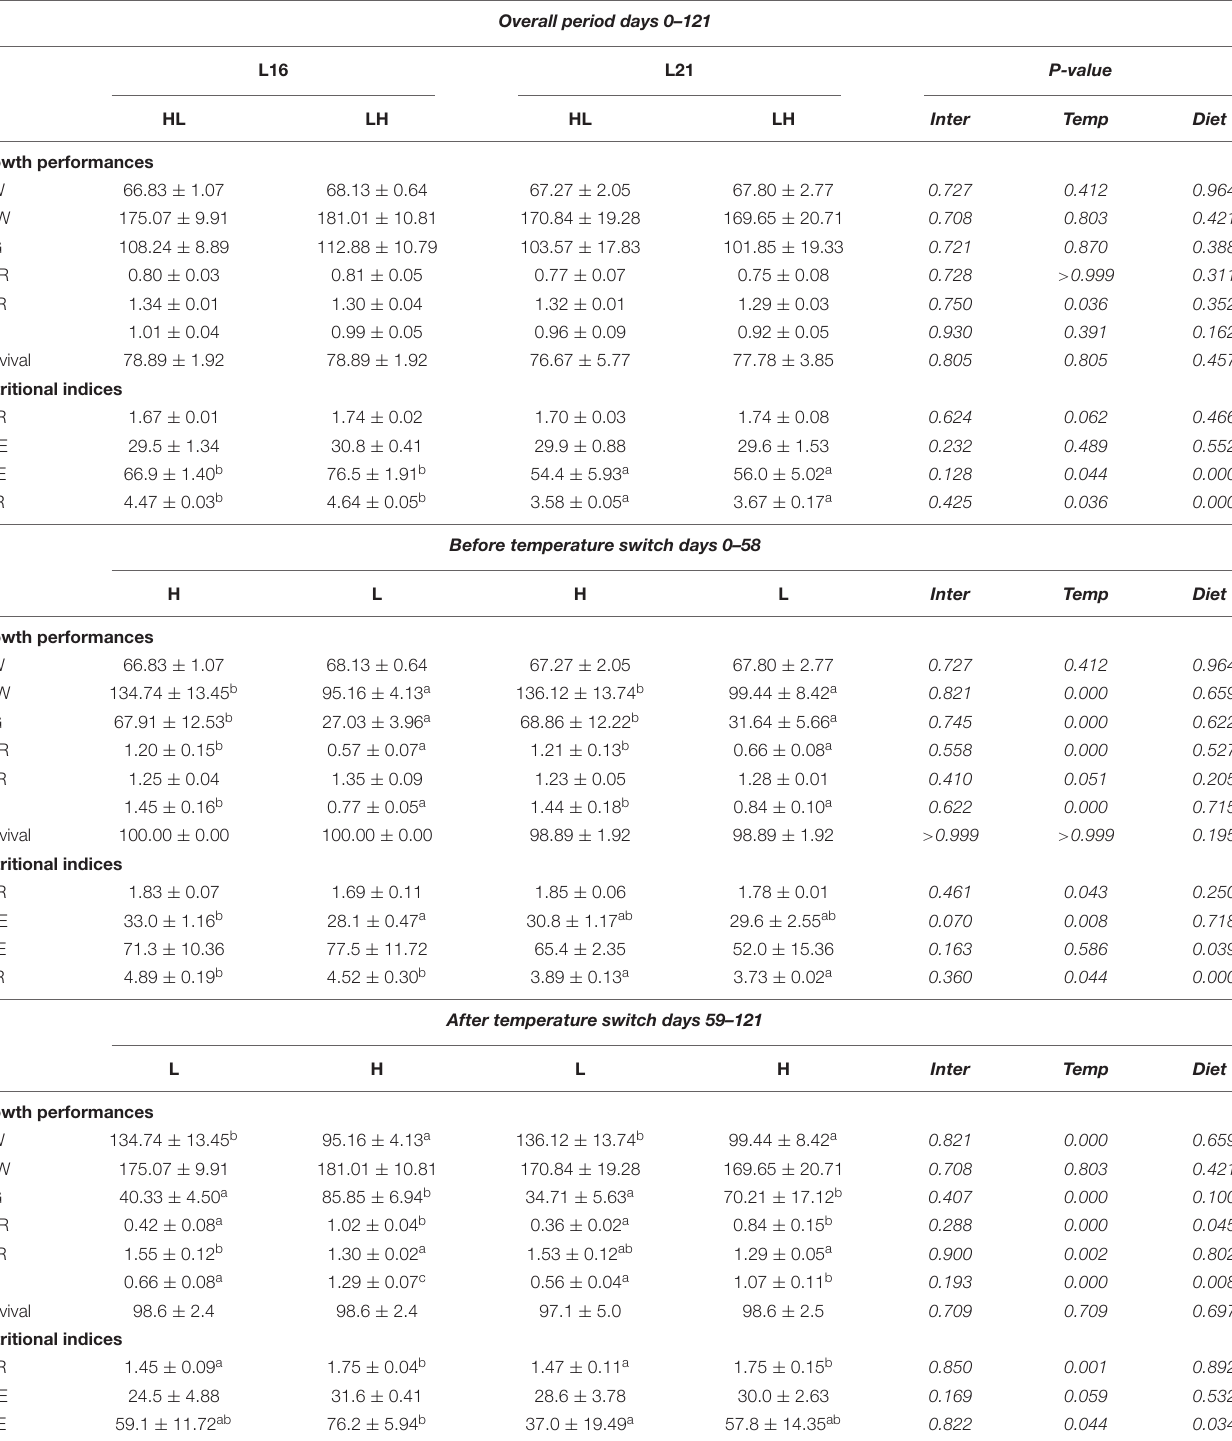
TABLE 2 | Growth performance and nutritional indices of gilthead sea bream fed experimental diets and exposed to water temperature switch. Overall period days